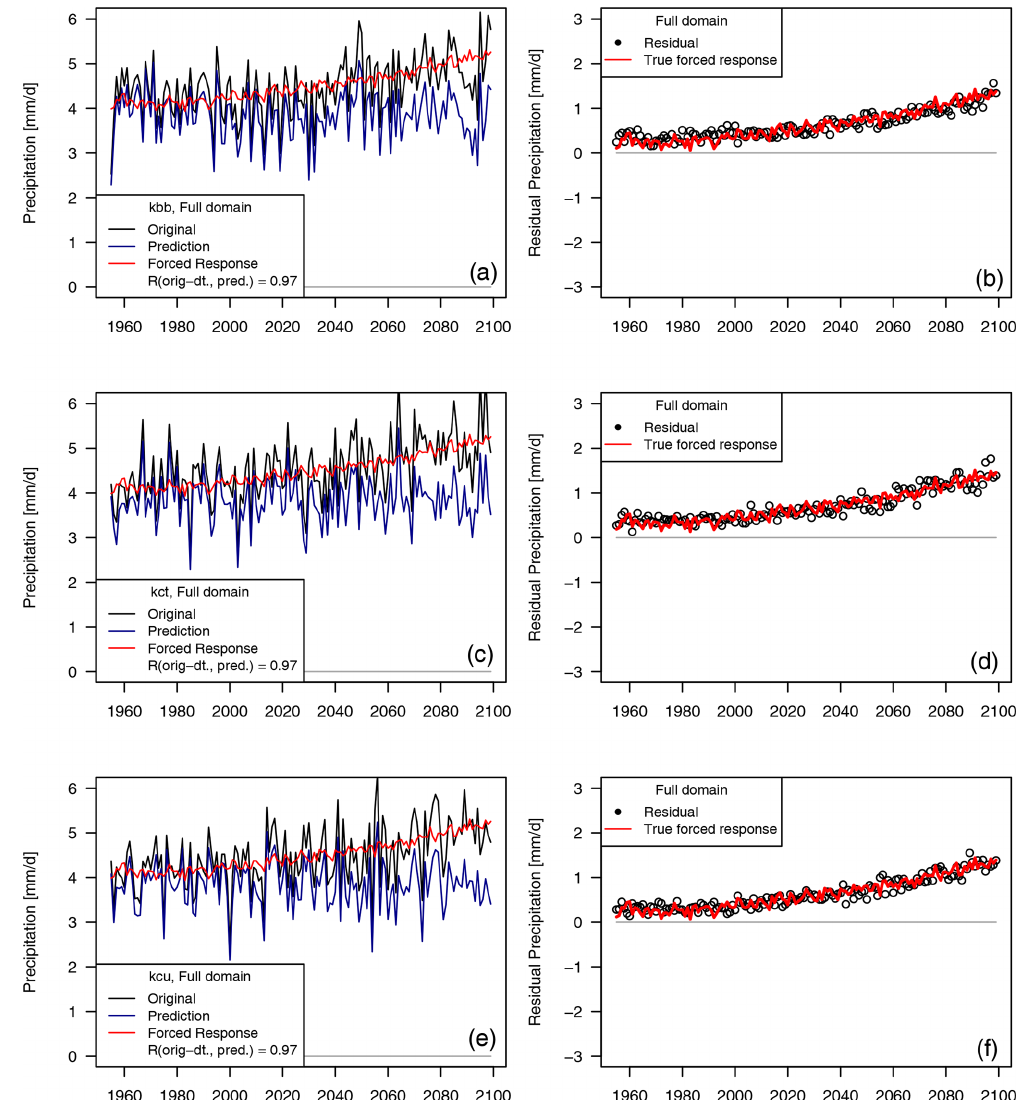
Figure 6. Dynamical adjustment of the full domain (land grid cells only) using autoencoders; (left) seasonal precipitation totals simulated by three members of the high-resolution RCM in black (top: “kbb”, middle: “kct”, bottom: “kcu”), the predicted (“circulation-induced”) component for three “holdout” ensemble members (blue), and the forced response (average across all 50 members, red); (right) residuals from the prediction (black dots) and the forced response